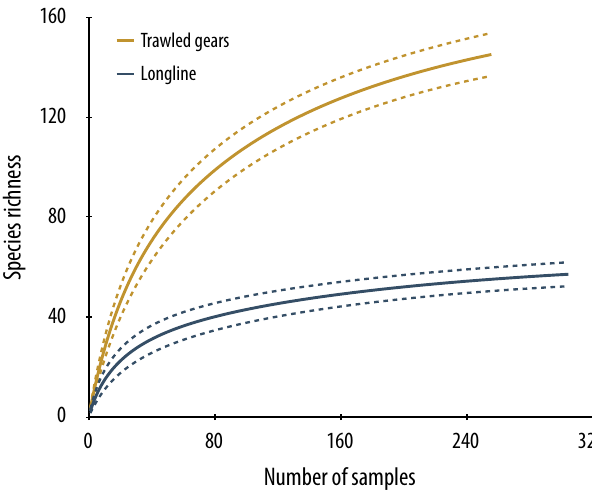
Fig. 5 . Sample-based rarefaction curves for coral fauna by trawled and bottom longline gears. Expected species richness values were calculated using the Mao Tau moment-based estimator with 95% confidence intervals (dashed